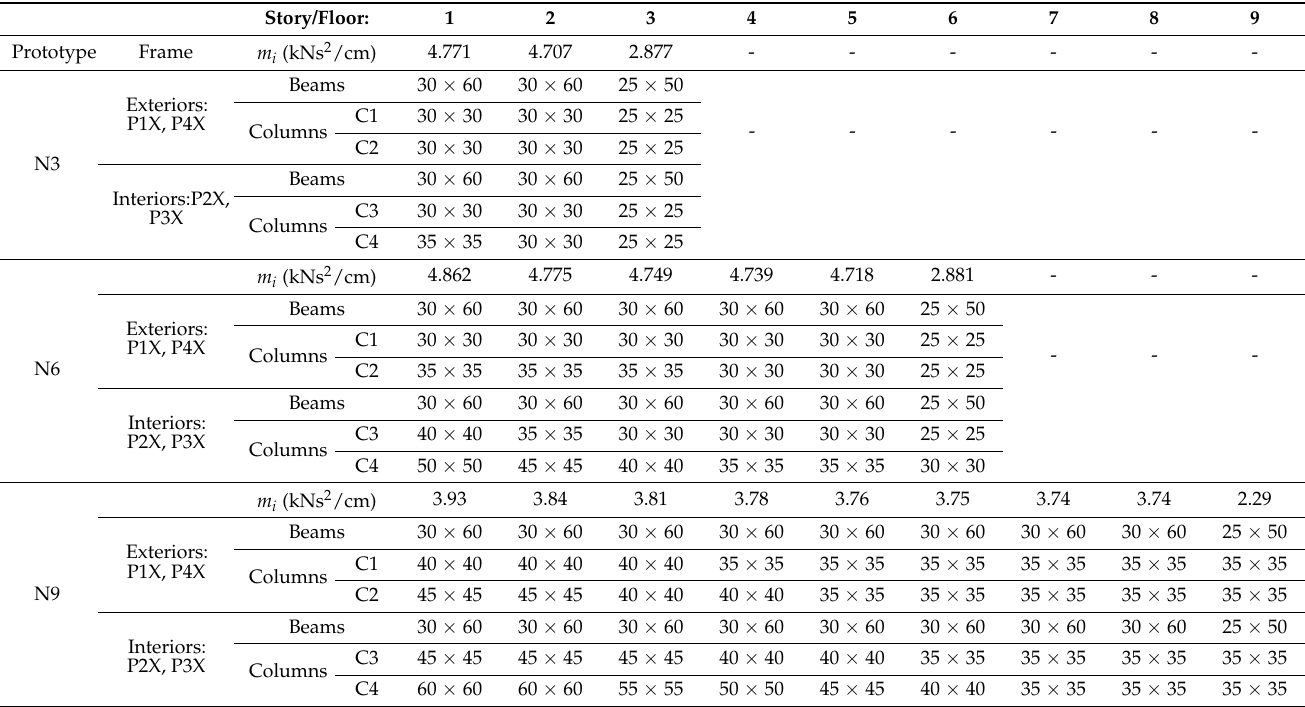
Table 2. Element sections of the prototypes (dimensions in